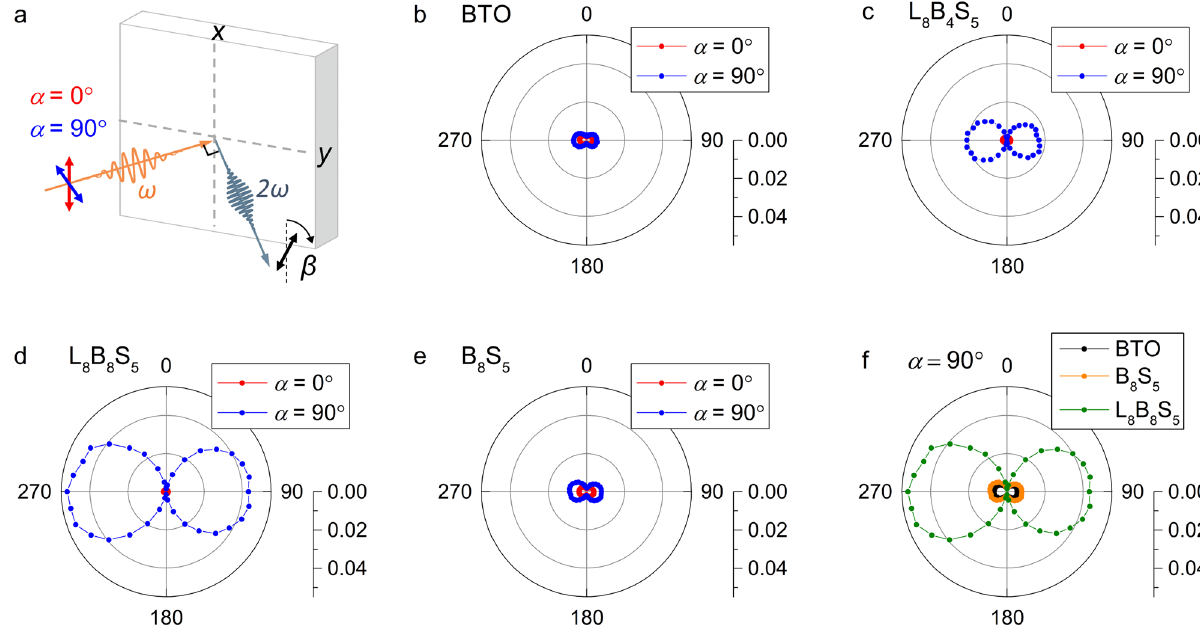
Fig. 4 Optical SHG characterizations of LMO/BTO/STO SLs. a Schematic of the SHG setup. b – e SHG analyzer measurements for the 40-uc BTO single fi lm, L 8 B 4 S 5 , L 8 B 8 S 5 and B 8 S 5 SLs grown on Si/STO measured with a polarizer angle α = 0° and α = 90°. f SHG signal at a fi xed polarizer angle of α = 90° comparing the 40-uc BTO, the bicolor B 8 S 5 SL, and the tricolor L 8 B 8 S 5